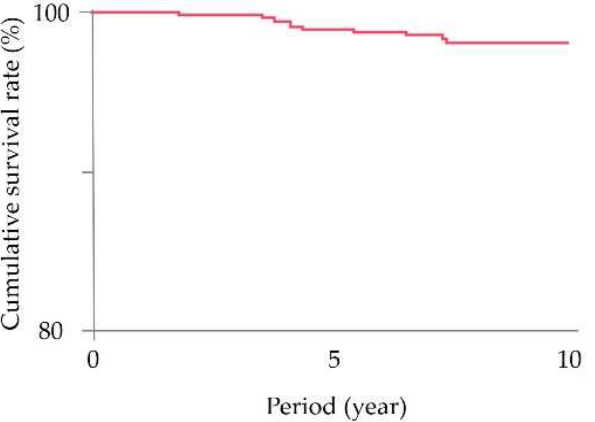
Figure 1. Kaplan–Meier curves of implants in elderly patients with implant-supported fixed dental prostheses. Table 4. The cumulative survival rates of implants up to 10 years.